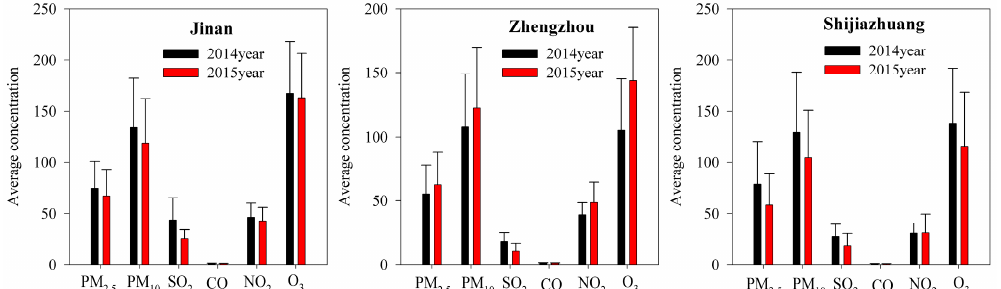
Figure 6. The average concentration of the principal air pollutants in Jinan, Zhengzhou, and Shijiazhuang in autumn (2014 and 2015). Units: PM 2.5 ( μ g/m − 3 ), PM 10 ( μ g/m − 3 ), CO (mg/m − 3 ), SO 2 ( μ g/m − 3 ), NO 2 ( μ g/m − 3 ), and O 3 ( μ g/m − 3 )